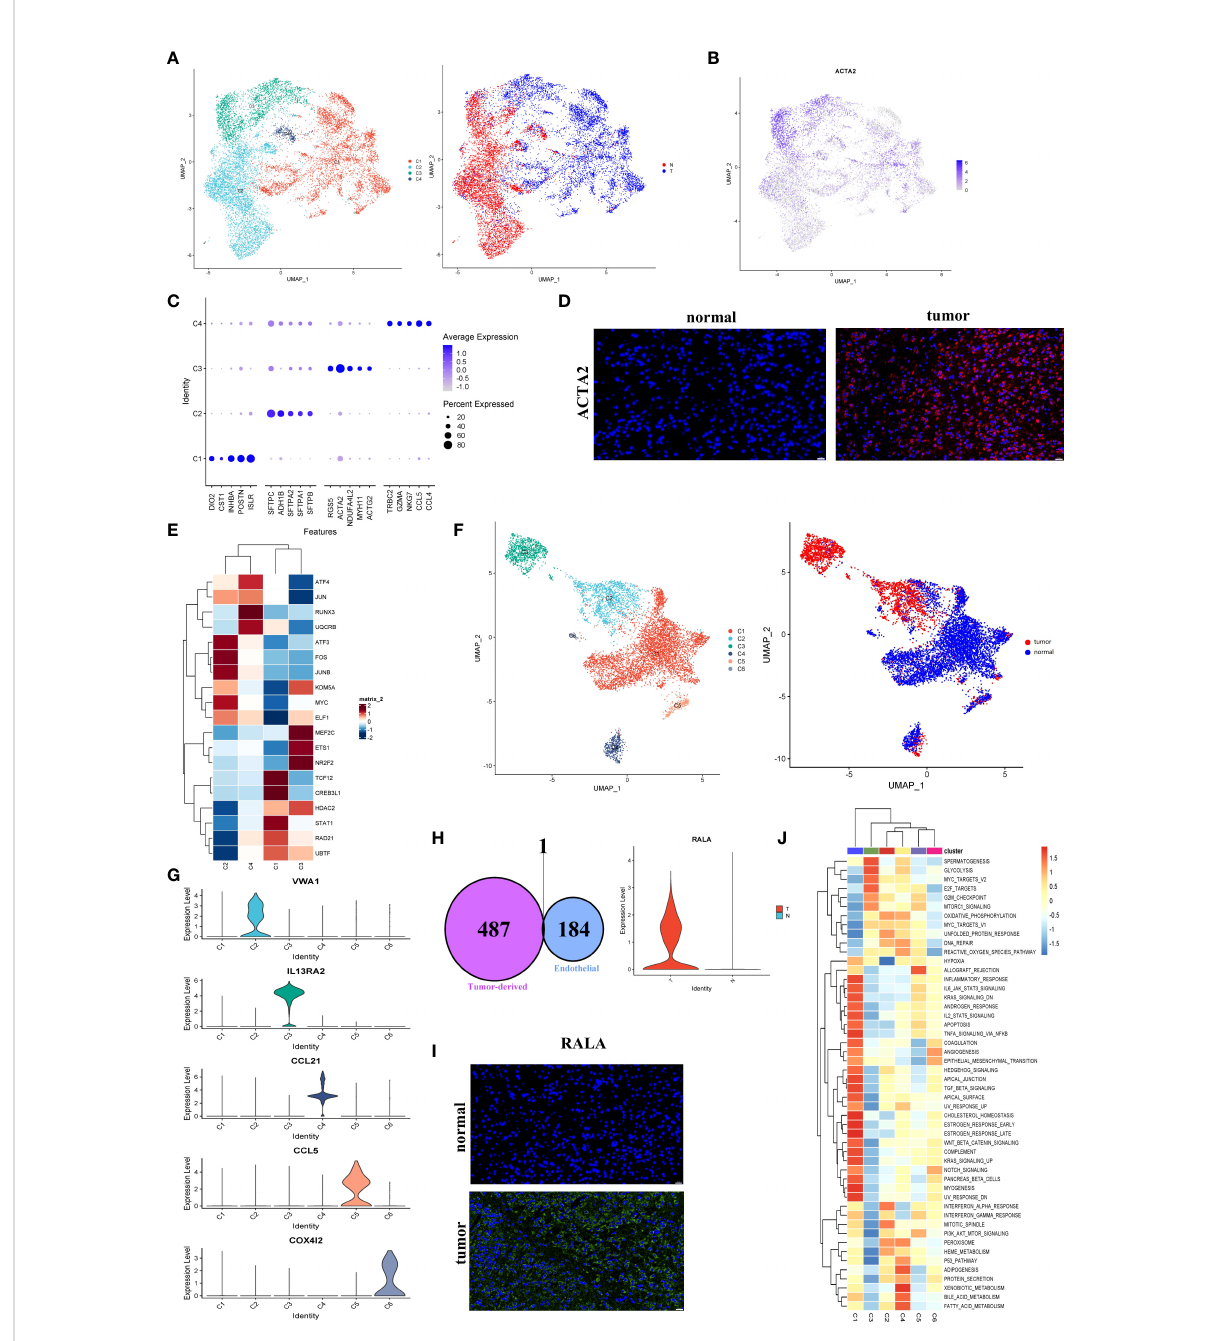
FIGURE 5 Fibroblasts and endothelial cells demonstrated high heterogeneity in LUAD. (A) UMAP plot of four fi broblast clusters and tissue type origin (normal or tumor). (B) UMAP plot of the expression level of ACTA2. (C) The top fi ve markers of four clusters were shown on the dot plot; color represented expression level, and sizes represented abundance. (D) Immuno fl uorescence of ACTA2 in tissue sections. The scale bar represented 20 µm. (E) The heatmap showed the transcription factors ’ activity through SCENIC estimated AUC scores in fi broblast. (F) The endothelial cells were color-coded (left) for six endothelial clusters and (right) for tissues of normal or tumor origin. (G) The marker gene for different endothelial clusters. (H) The Venn diagram intersected the endothelial-speci fi c markers and the DEGs between different endothelial cell types (tumor and normal). One overlapped gene was identi fi ed (left). The expression level of RALA was visualized by the violin plots (right). (I) The immuno fl uorescence of RALA in LUAD or normal tissue sections. The RALA was upregulated in LUAD tissue. The scale bar represented 20 µm. (J) The GSVA estimated the 50 hallmark pathway activities in the different cell